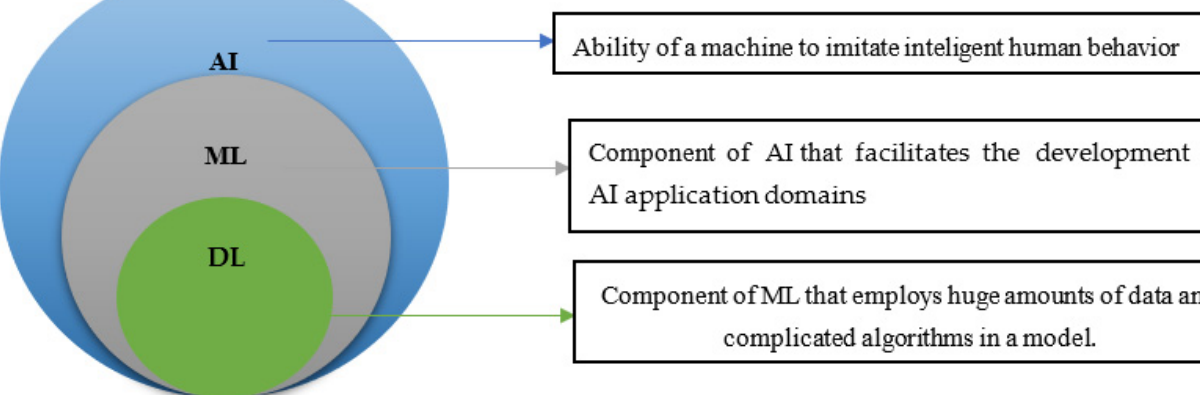
Figure 5. Relationship between AI, ML, and DL.